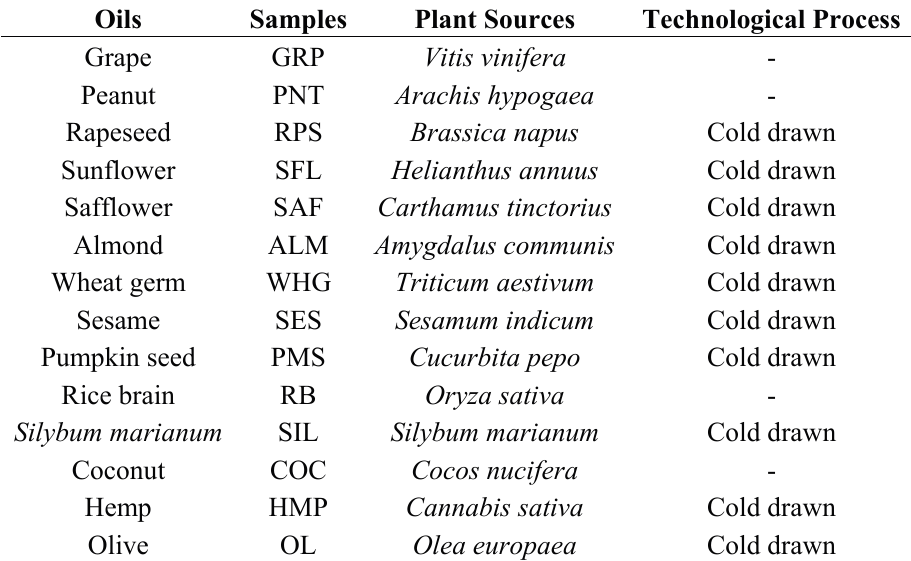
Table 5. Description of analyzed samples of vegetable